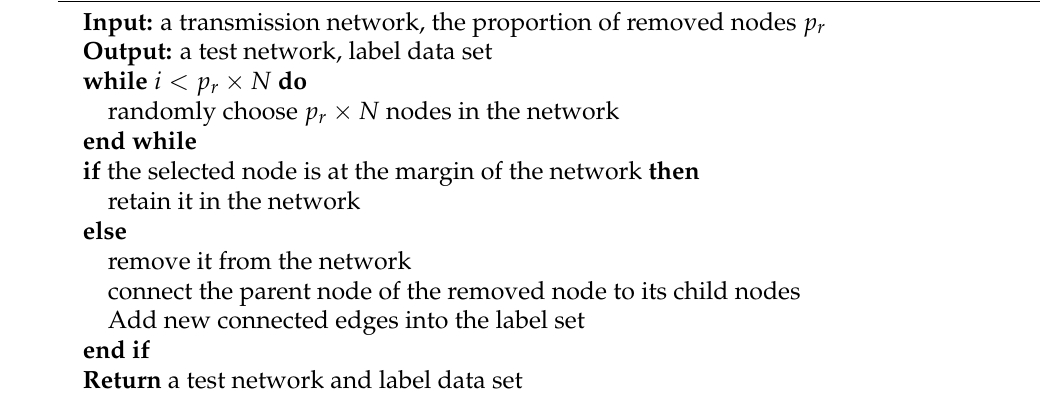
Algorithm 2 Test transmission network and label data